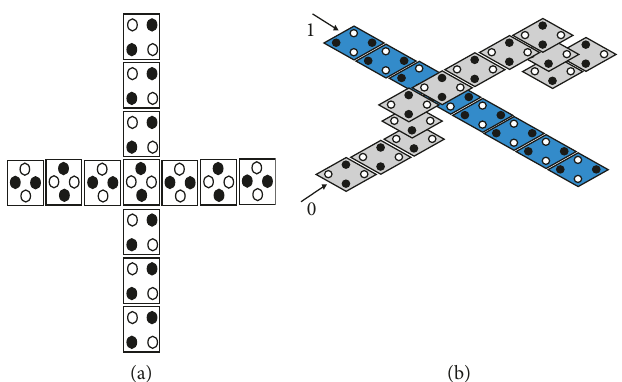
Figure 4: Signal crossover schemes. (a) Coplanar crossing. (b) Multilayer